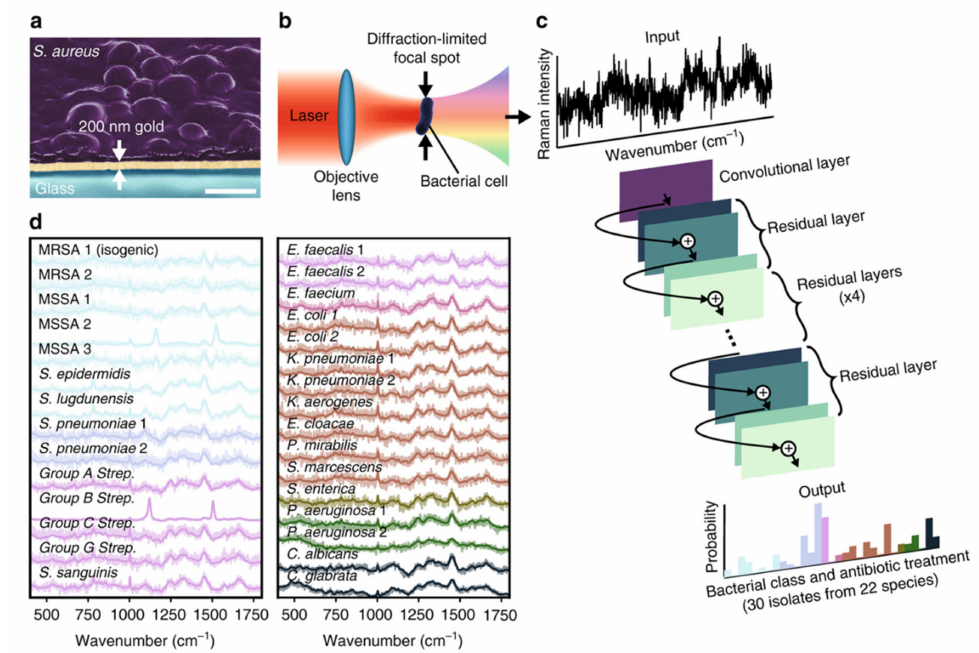
Figure 3. Rapid identification of bacteria and antibiotic susceptibility by Raman spectroscopy and deep learning. ( a ) Bacterial cells deposited onto gold-coated silica substrates. The scale bar is 1 µ m. ( b ) Conceptual measurement schematic: by focusing the excitation laser source to diffraction-limited spot size, Raman signal from single cells can be acquired. ( c ) Classification of bacteria from low-signal Raman spectra using a one-dimensional residual network with 25 total convolutional layers. ( d ) Averages of 2000 Raman spectra from 30 isolates are shown in bold and overlaid on representative examples of noisy single spectra for each isolate. Spectra are color-grouped according to empiric antibiotic treatment. Reprinted from reference [74] with